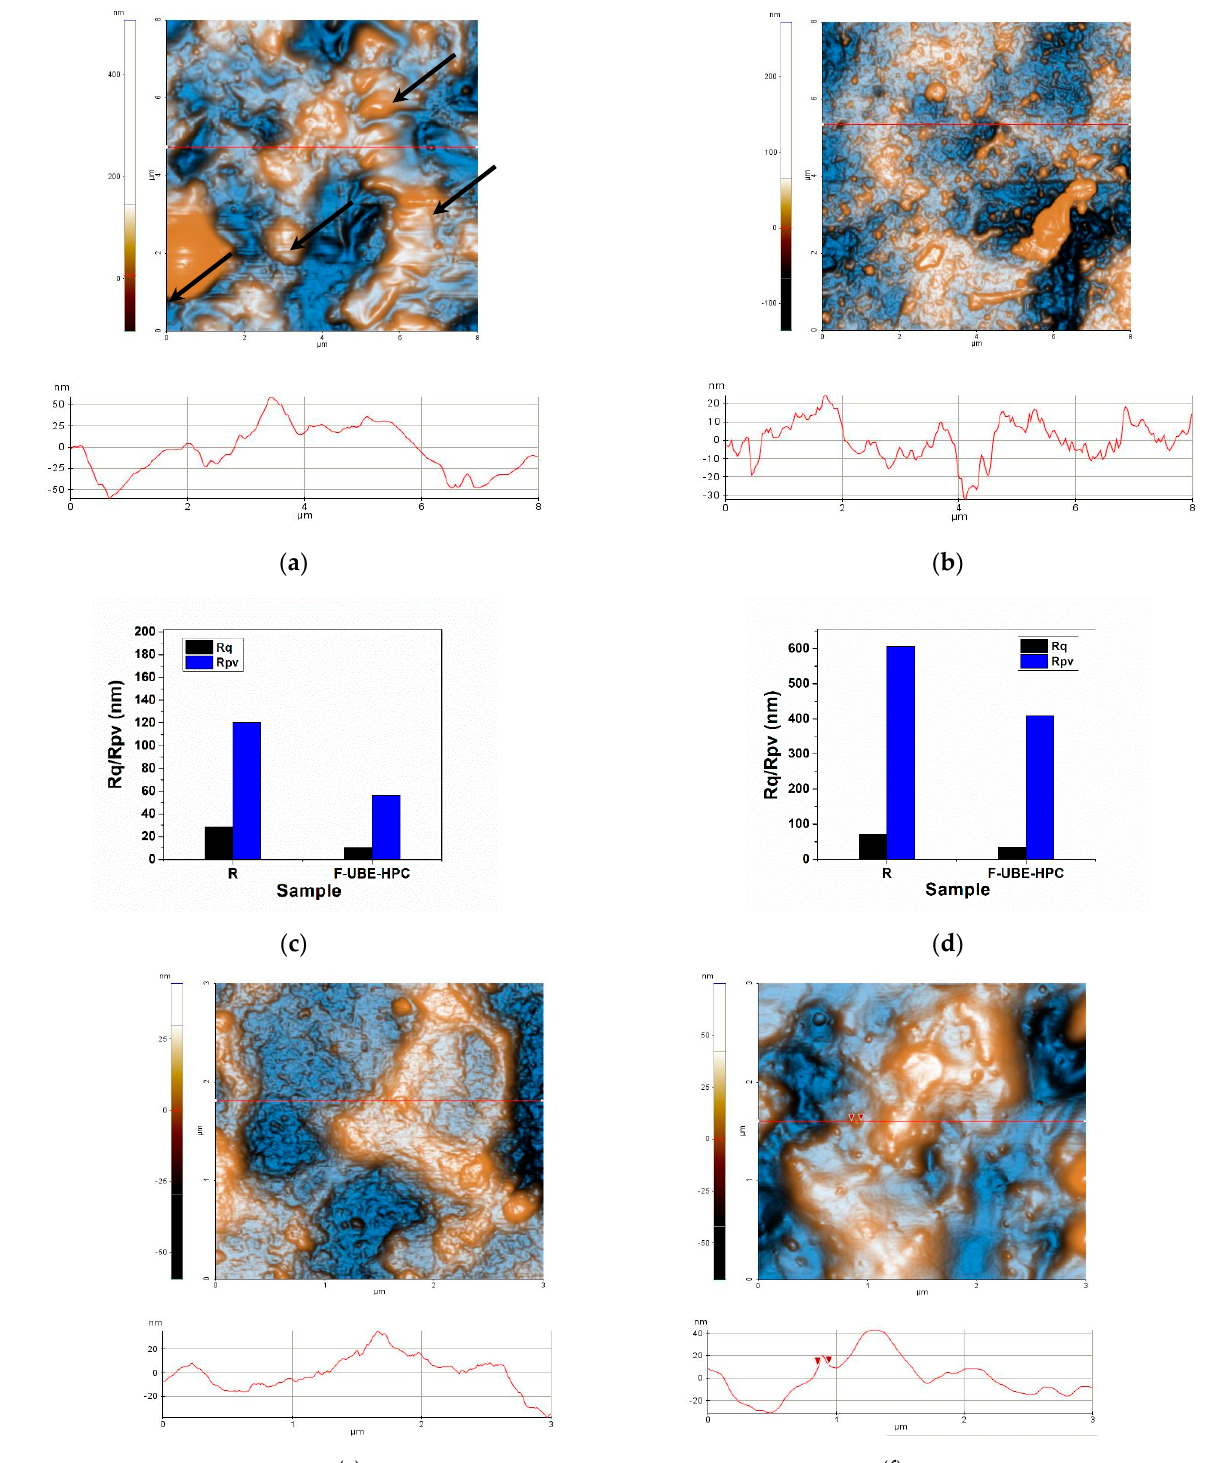
Figure 2. The 2D AFM images (enhanced contrast view) at the scale of (8 × 8) µm 2 together with